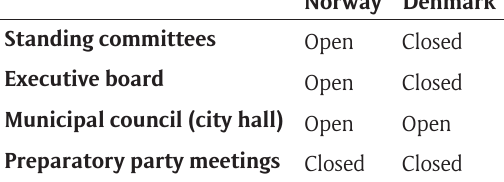
Table 1: Openness in various political bodies in Norwegian and Danish